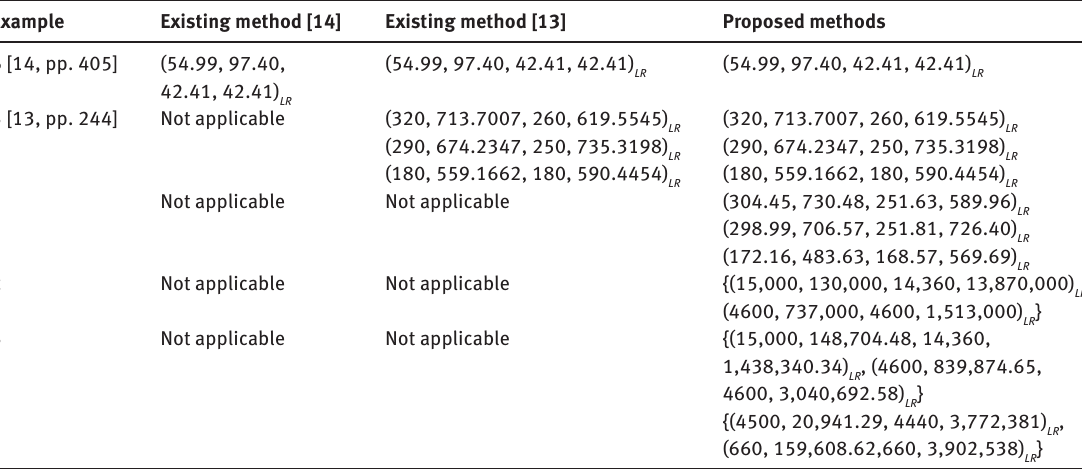
Table 8: Comparison of Results Obtained Using Existing Methods and Method Proposed in This Article.